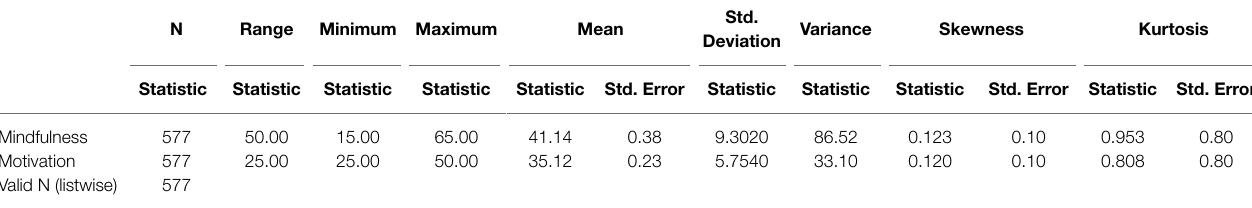
TABLE 4 | Descriptive statistics for the mindfulness and motivation questionnaires.